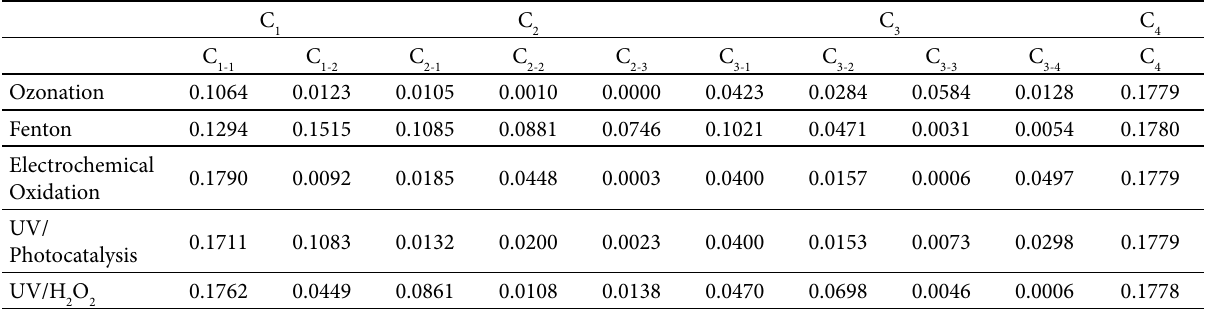
Table 11. WASPAS weighted and normalized decision making matrix for summarizing